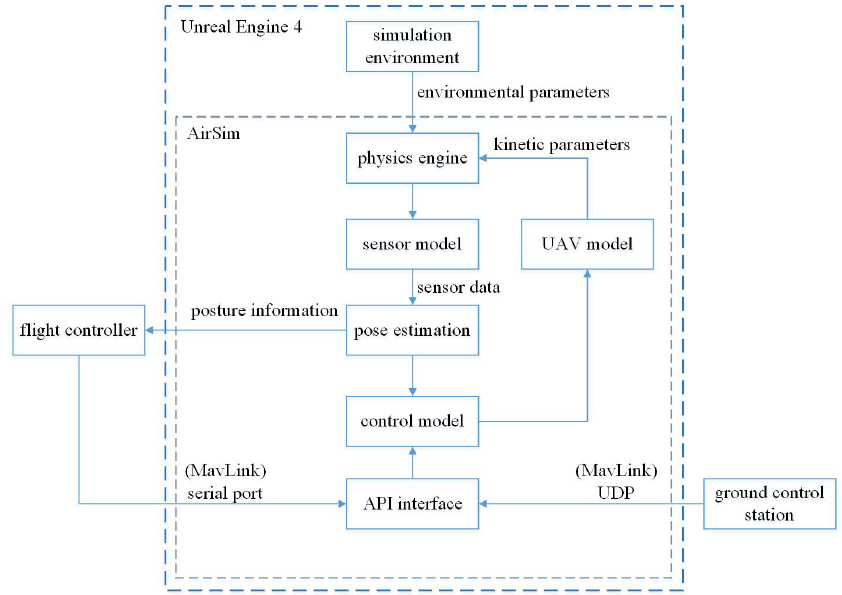
Figure 7. AirSim simulation system.